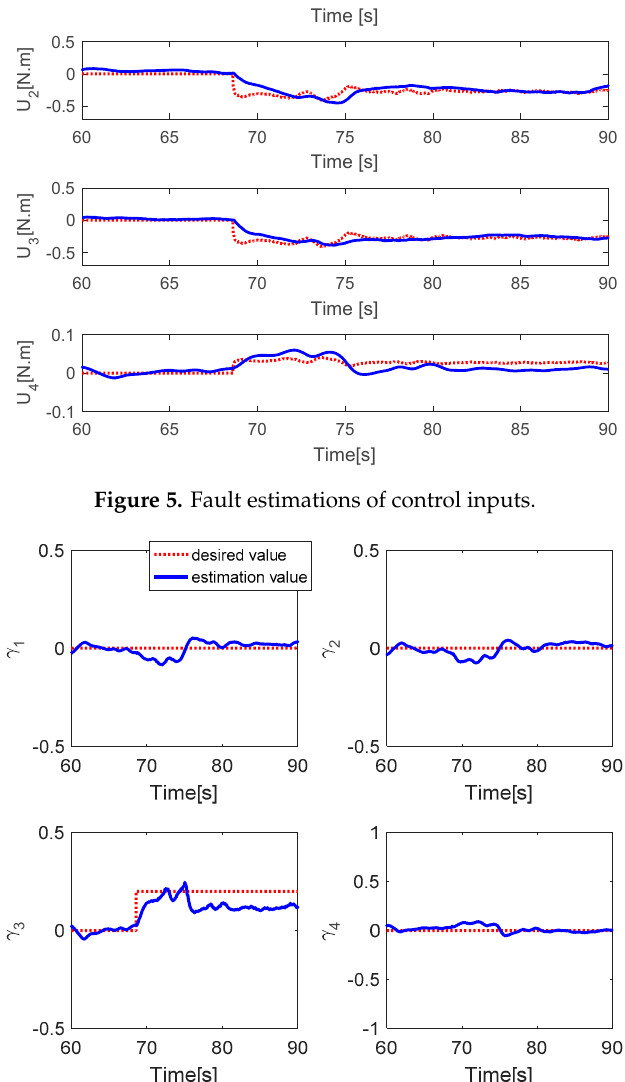
Figure 6. Fault estimation of each actuator.